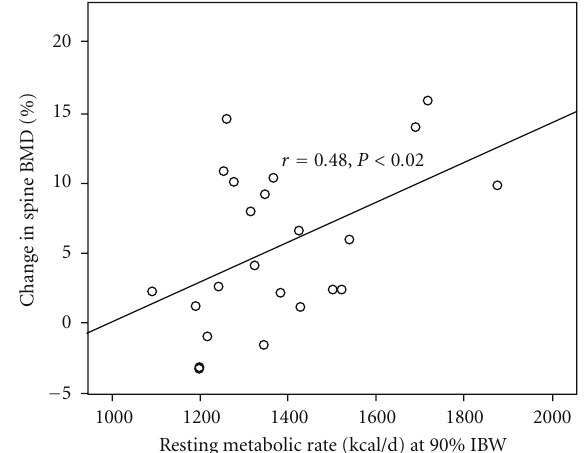
Figure 2: Correlation between resting metabolic rate of patients at 90% IBW and % change in leg BMD. Each circle represents the data point of a